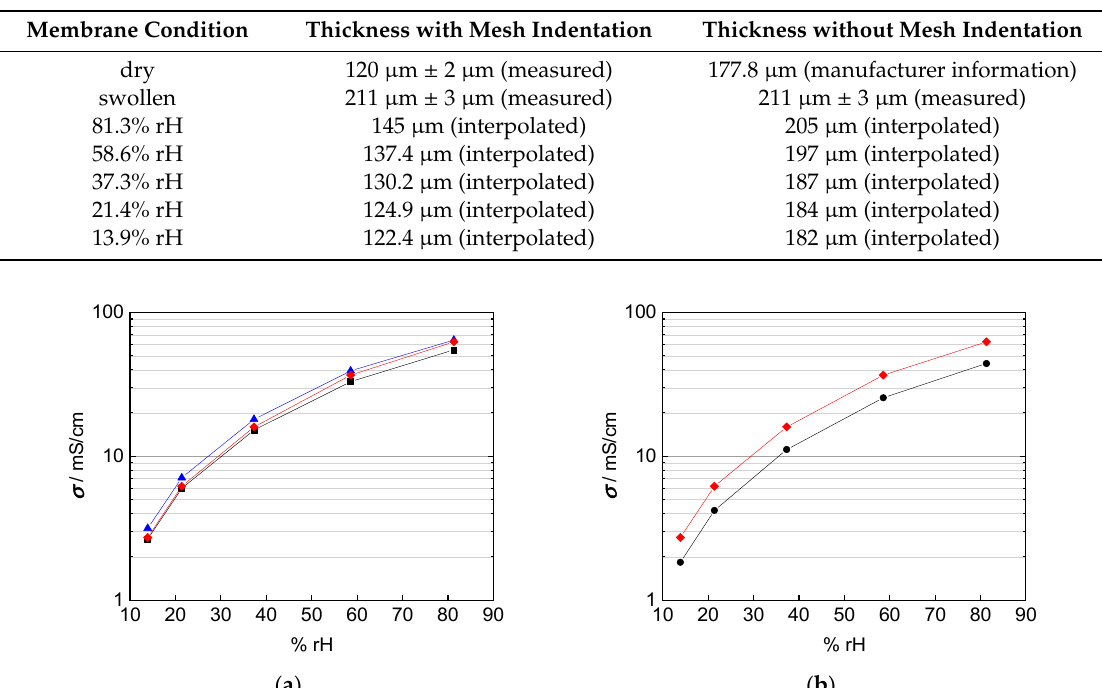
Table 3. Measured and interpolated thickness for Nafion 117 at different moisture conditions with and without mesh indentation.